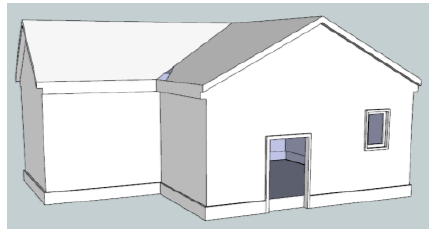
Figure 4 . The building model (single storey house) used for the case study.